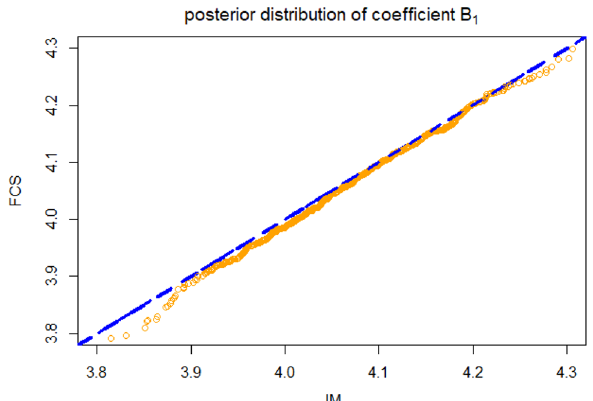
Figure 1. qqplot demonstrating the closeness of the posterior distribution of JM and FCS for β 1